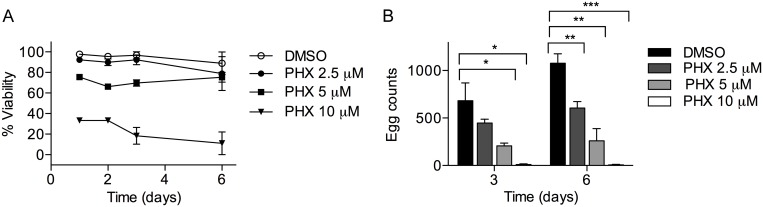
Effect of PHX on adult S. mansoni worm couples and on egg production in vitro.Adult couples were incubated with the indicated doses of PHX and viability and total egg counts assessed as described in the methods section. A) viability curves of adult worm couples; B) total egg counts normalized to worm couples. The mean values ± SEM are shown, the data are representative of three independent experiments. * indicates p values < 0.05, ** indicates p values < 0.01 and *** indicates p values < 0.001.